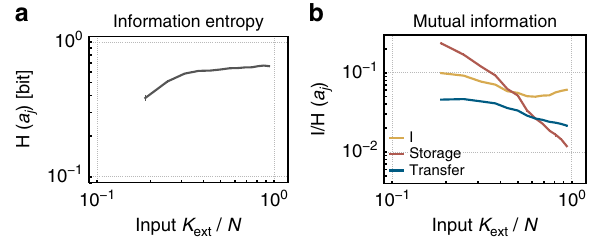
Fig. 8 The information fi ngerprint changes with the degree of input K ext , thus with distance to criticality. a The entropy (H) of the spiking activity of a single neuron, a j stays fairly constant, except for low K ext as a consequence of decreasing fi ring rates. b The mutual information (I) between the activity of two units a i , a j increases with lower K ext (i.e., closer to critical). The network intrinsic memory also increases, indicated by the active information storage (AIS) I ð a j : a (cid:3) . Likewise, the information j Þ transfer within the network increases with lower K ext . Information transfer is measured as transfer entropy (TE) between pairs of neurons a j and a i ,